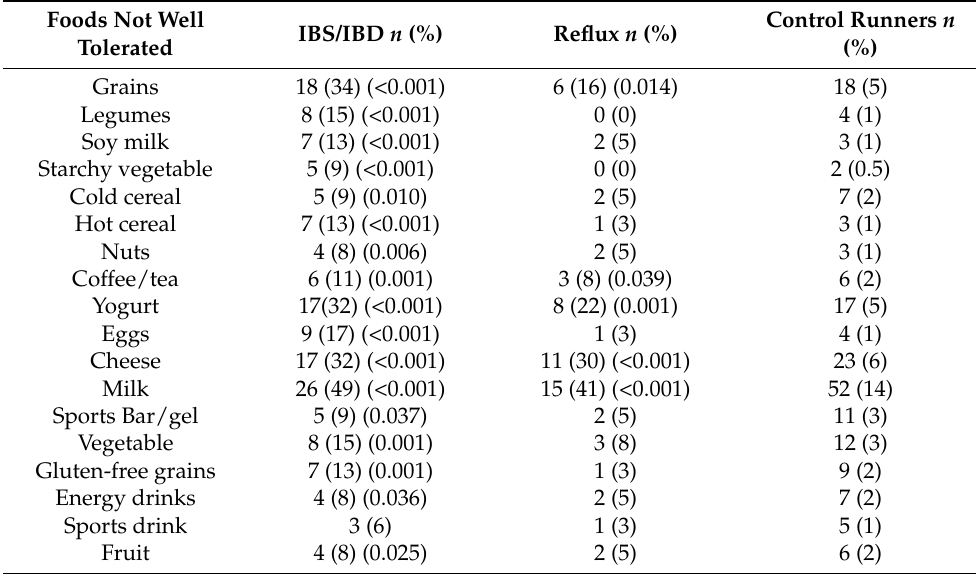
Table 2. Foods Not Well Tolerated.